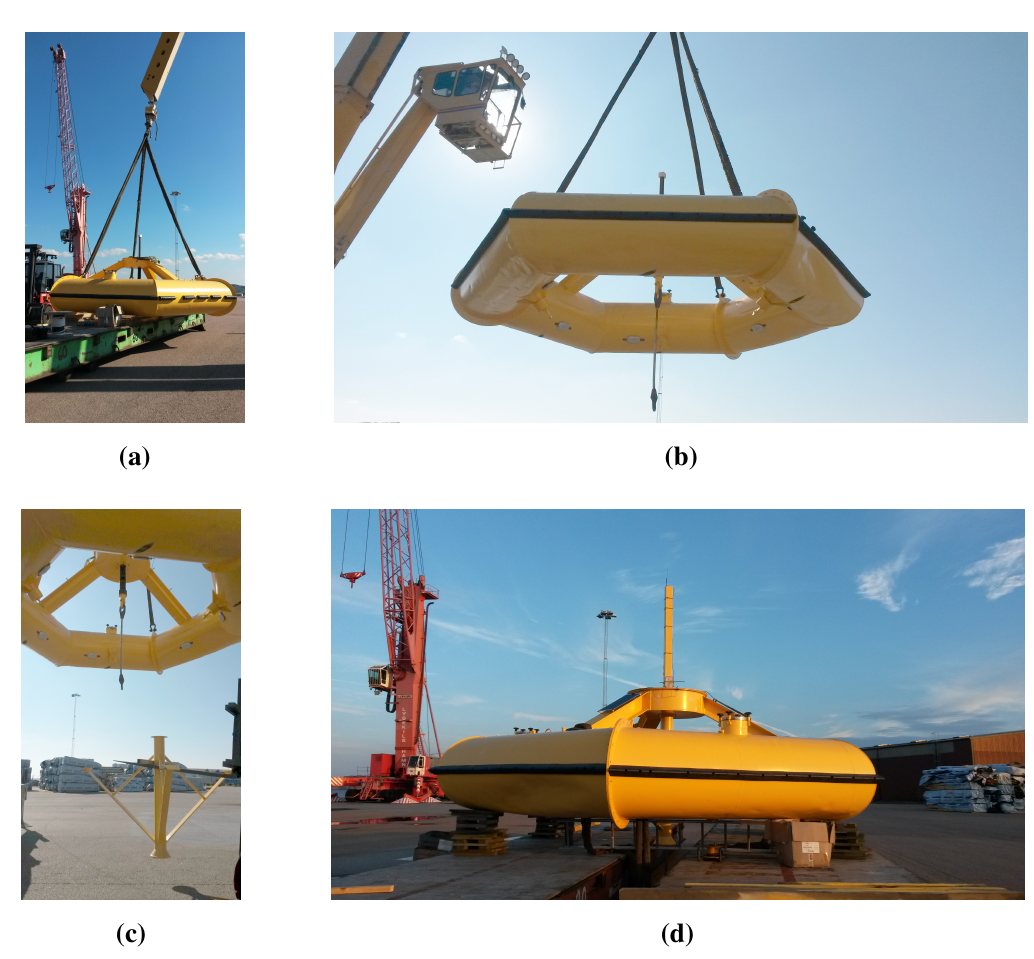
Figure 10. Pictures of the assembly. ( a ) A crane lifts the buoy; ( b ) the guiding line hangs underneath the screw; ( c ) the lower tube; ( d ) the buoy is placed on a barge, and the lid is